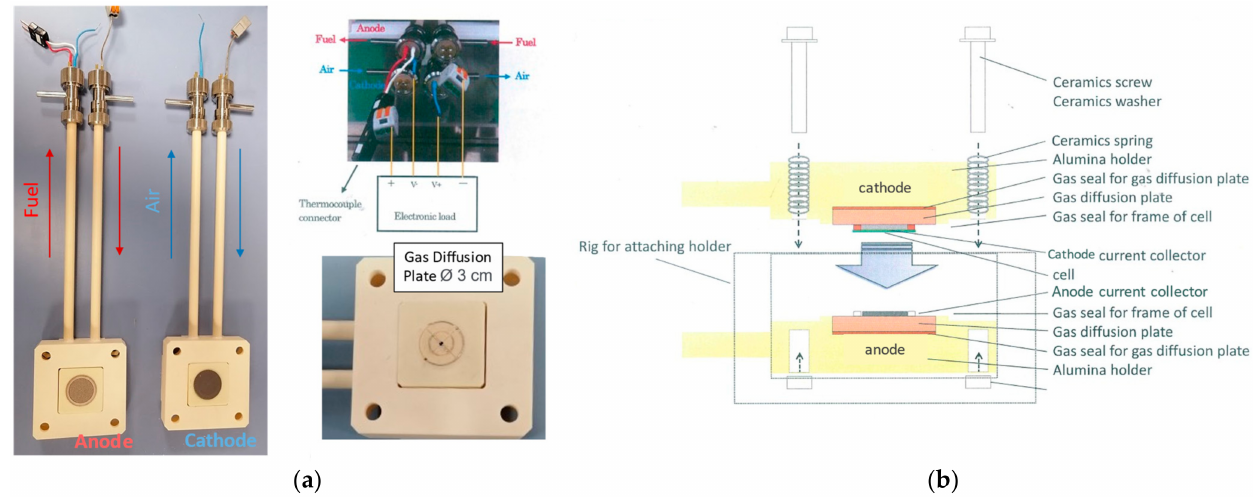
Figure 4. ( a ) All-Ceramic SOFC Test Holder used for the study; ( b ) schematization of cell assembly